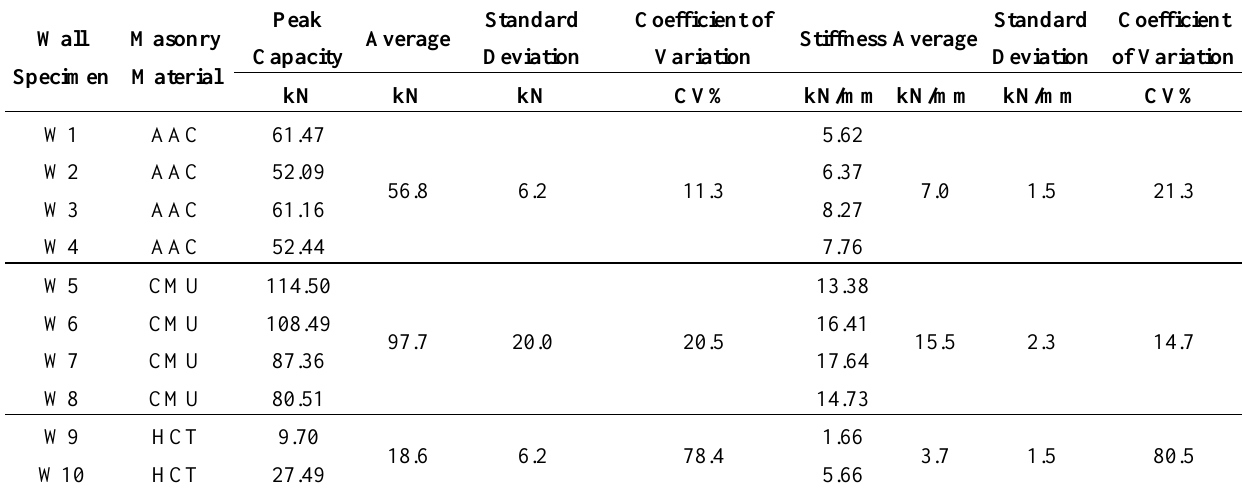
Table 1. Masonry wall panel shear tests results.